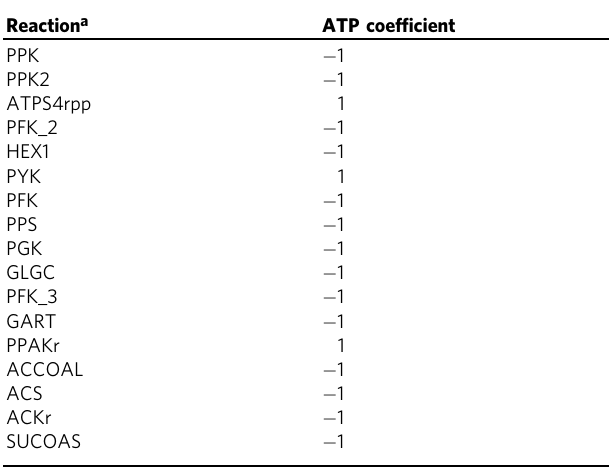
Table 1 Reactions that consume or produce ATP and corresponding stoichiometric coef fi